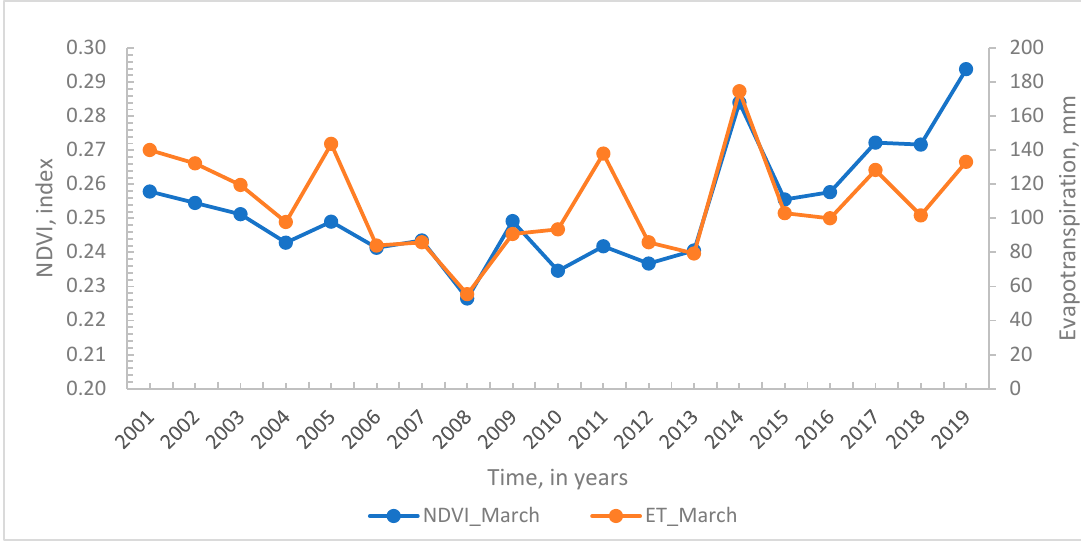
Figure 9. NDVI of Gumara River catchment in Dry season month of March between 2000 and 2019 and March Evapotranspiration over the Gumara catchment; satellite data of “MODIS Global Terrestrial Evapotranspiration 8-day Global 1km” resolution was used for the estimate.